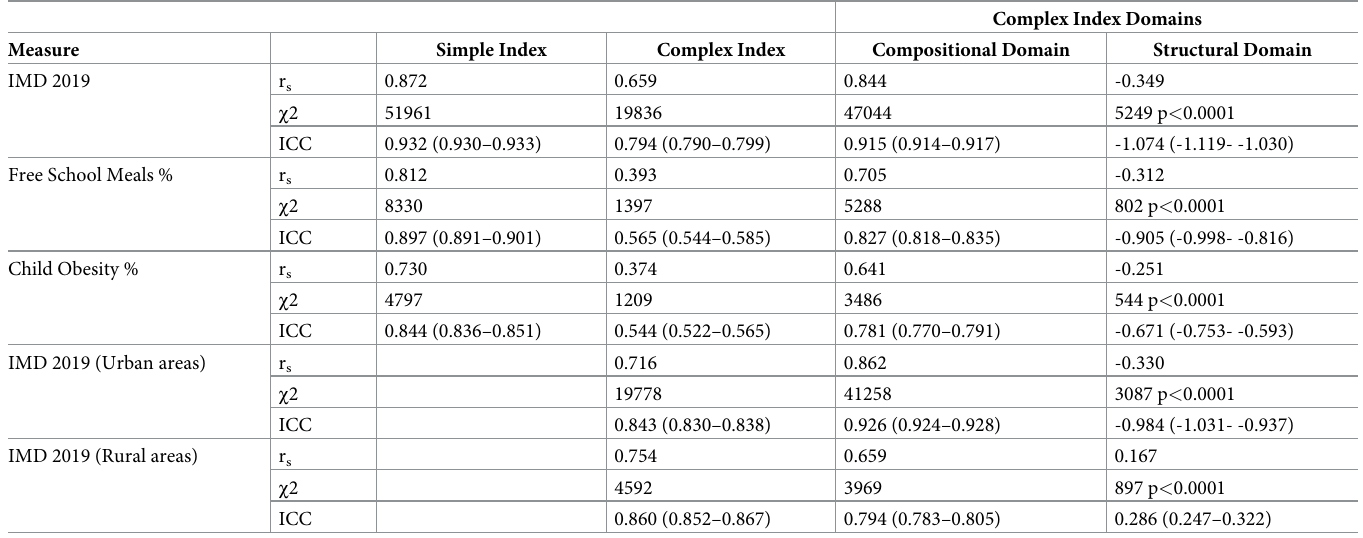
Table 4. Validation